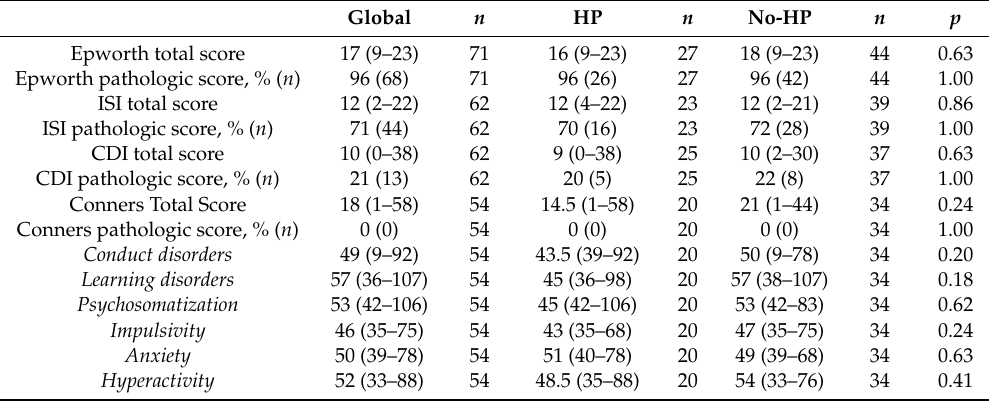
Table 4. Questionnaire scores in children with and without HP.